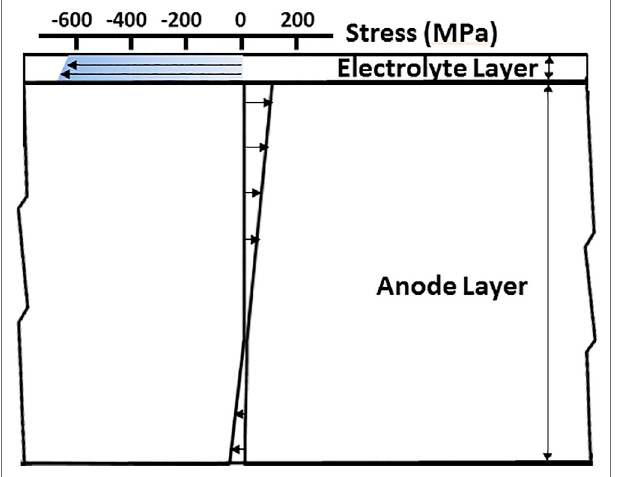
FIGURE 2 | Decrease in overall residual stress level at working temperature (compare with Figure 1